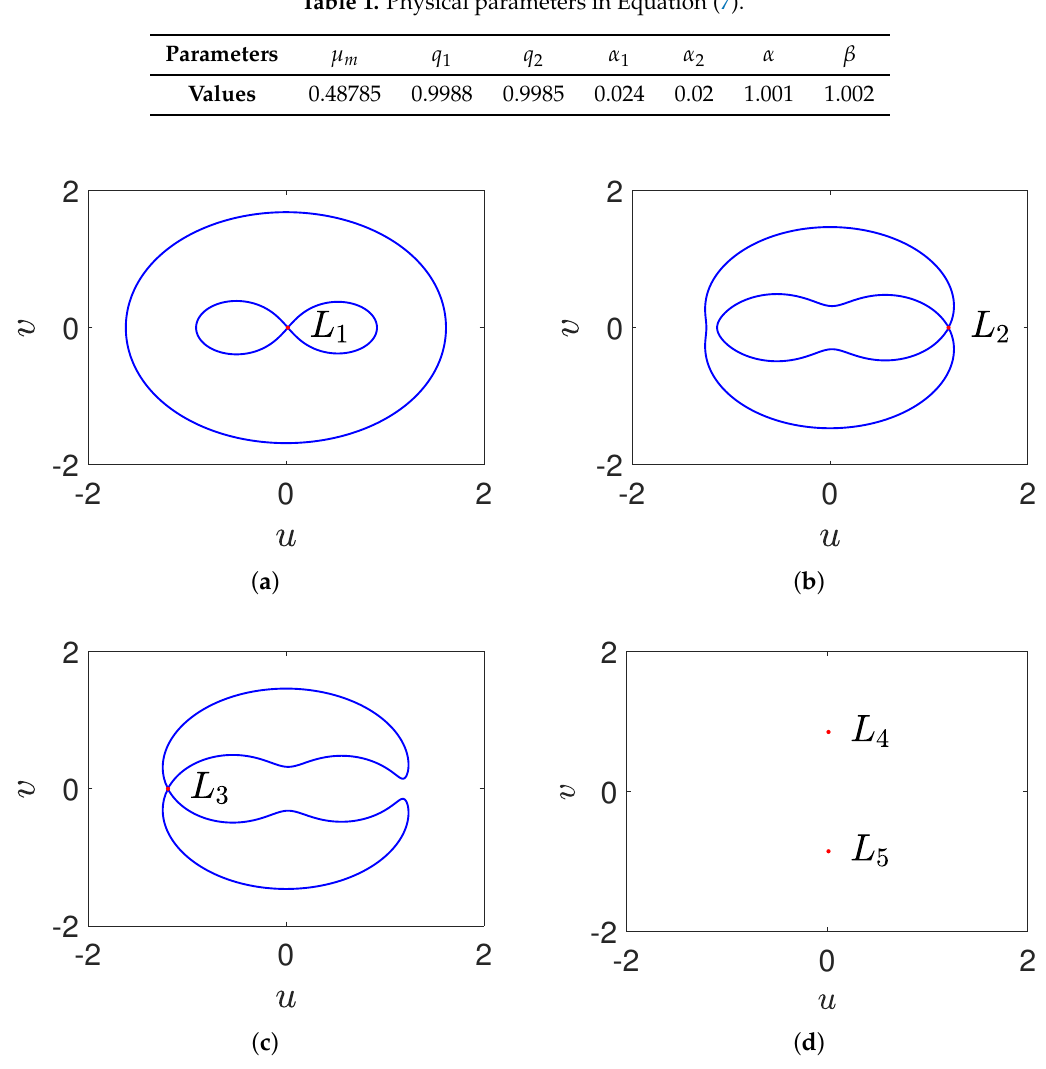
Figure 3. Zero-velocity curves of the third body: ( a ) C = 4.16993, ( b ) C = 3.59308, ( c ) C = 3.57940, ( d ) C =